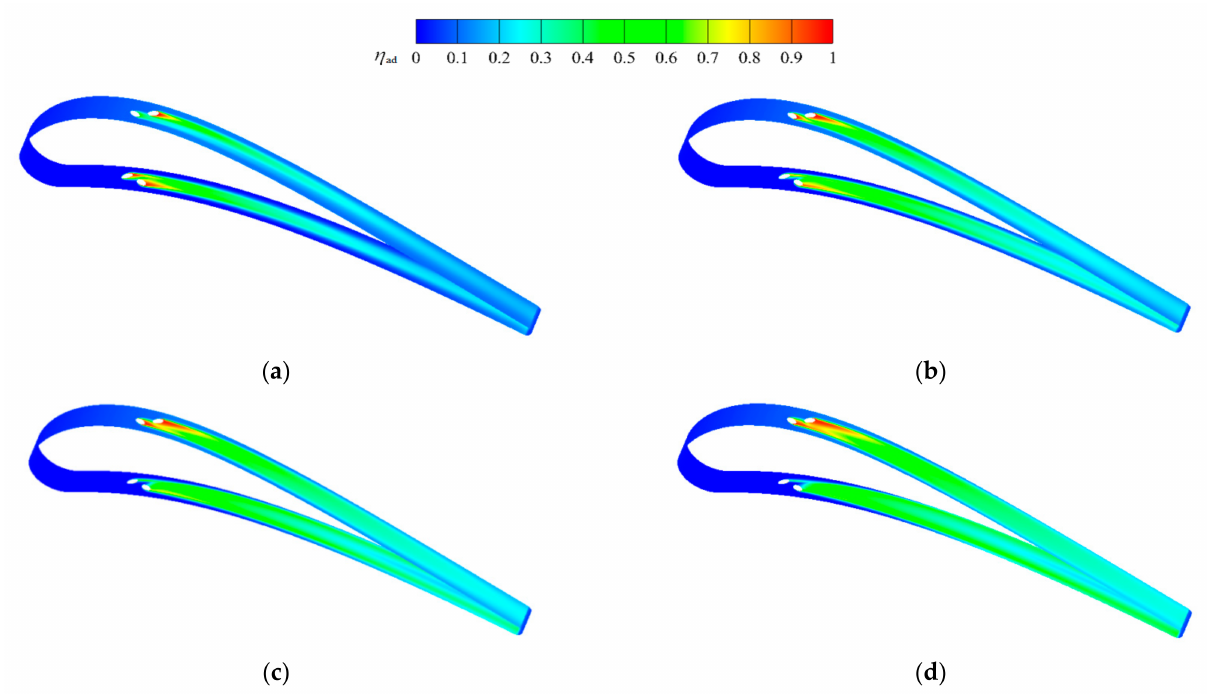
Figure 21. Local film cooling effectiveness distribution on the guide vane surface for DJFC with β = 23 ◦ and Z / d = 1.0. ( a ) M = 0.5, ( b ) M = 1.0, ( c ) M = 1.5, ( d ) M =